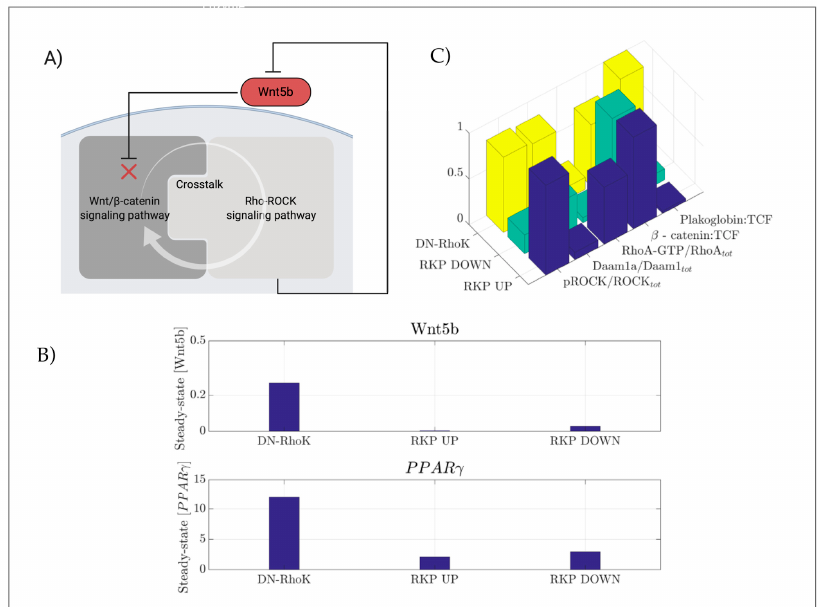
Figure 8. ( A ) Loop of negative feedback described in our model. ( B ) Trends of steady-state concentrations of Wnt5b (upper panel) and PPAR γ (bottom panel) in the three conditions analyzed (DN-RhoK, RKP UP and RKP DOWN). ( C ) Concentration of pROK (Rho active kinase), active Daam1 and RhoA-GTP, with respect to the total, normalized concentrations of the β -catenin-TCF and PG-TCF complexes in the three biological situations analyzed.